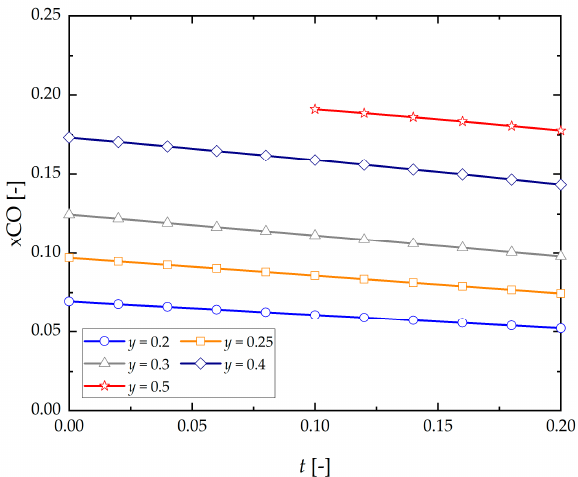
Figure 5. Change in equilibrium composition x H of gaseous phase (CH 4 /H 2 )–H 2 O.